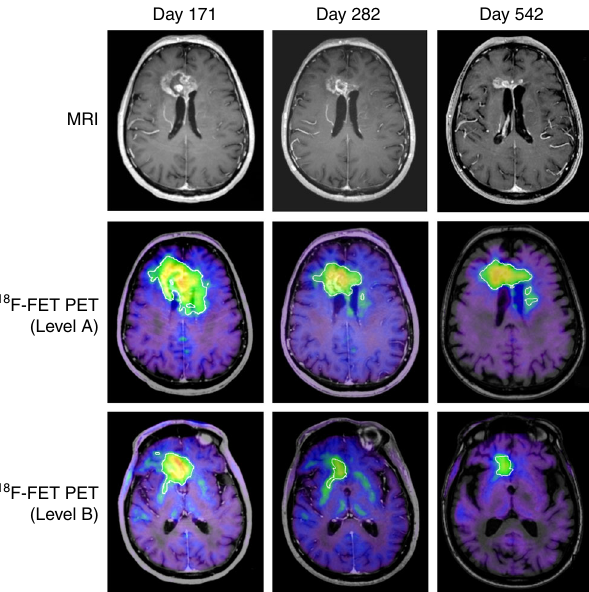
Fig. 6 Treatment response in Patient 3. This 76-year-old patient had a bilateral GBM tumor and was treated with radiation and concomitant temozolomide, with tumor progression four months into the temozolomide regimen. The patient received a total of eight injections of autologous cytotoxic lymphocytes, and stable disease was achieved within one month after the fi rst injection. The MR images (top panel) illustrate a continuous reduction in size of the contrast-enhancing lesion by 63% over a course of 542 days. The middle and lower panels represent FET-PET images at two different levels of the brain, showing a 50% reduction in metabolically active tumor volume over the course of one year. The green areas represent the invasive parts of the